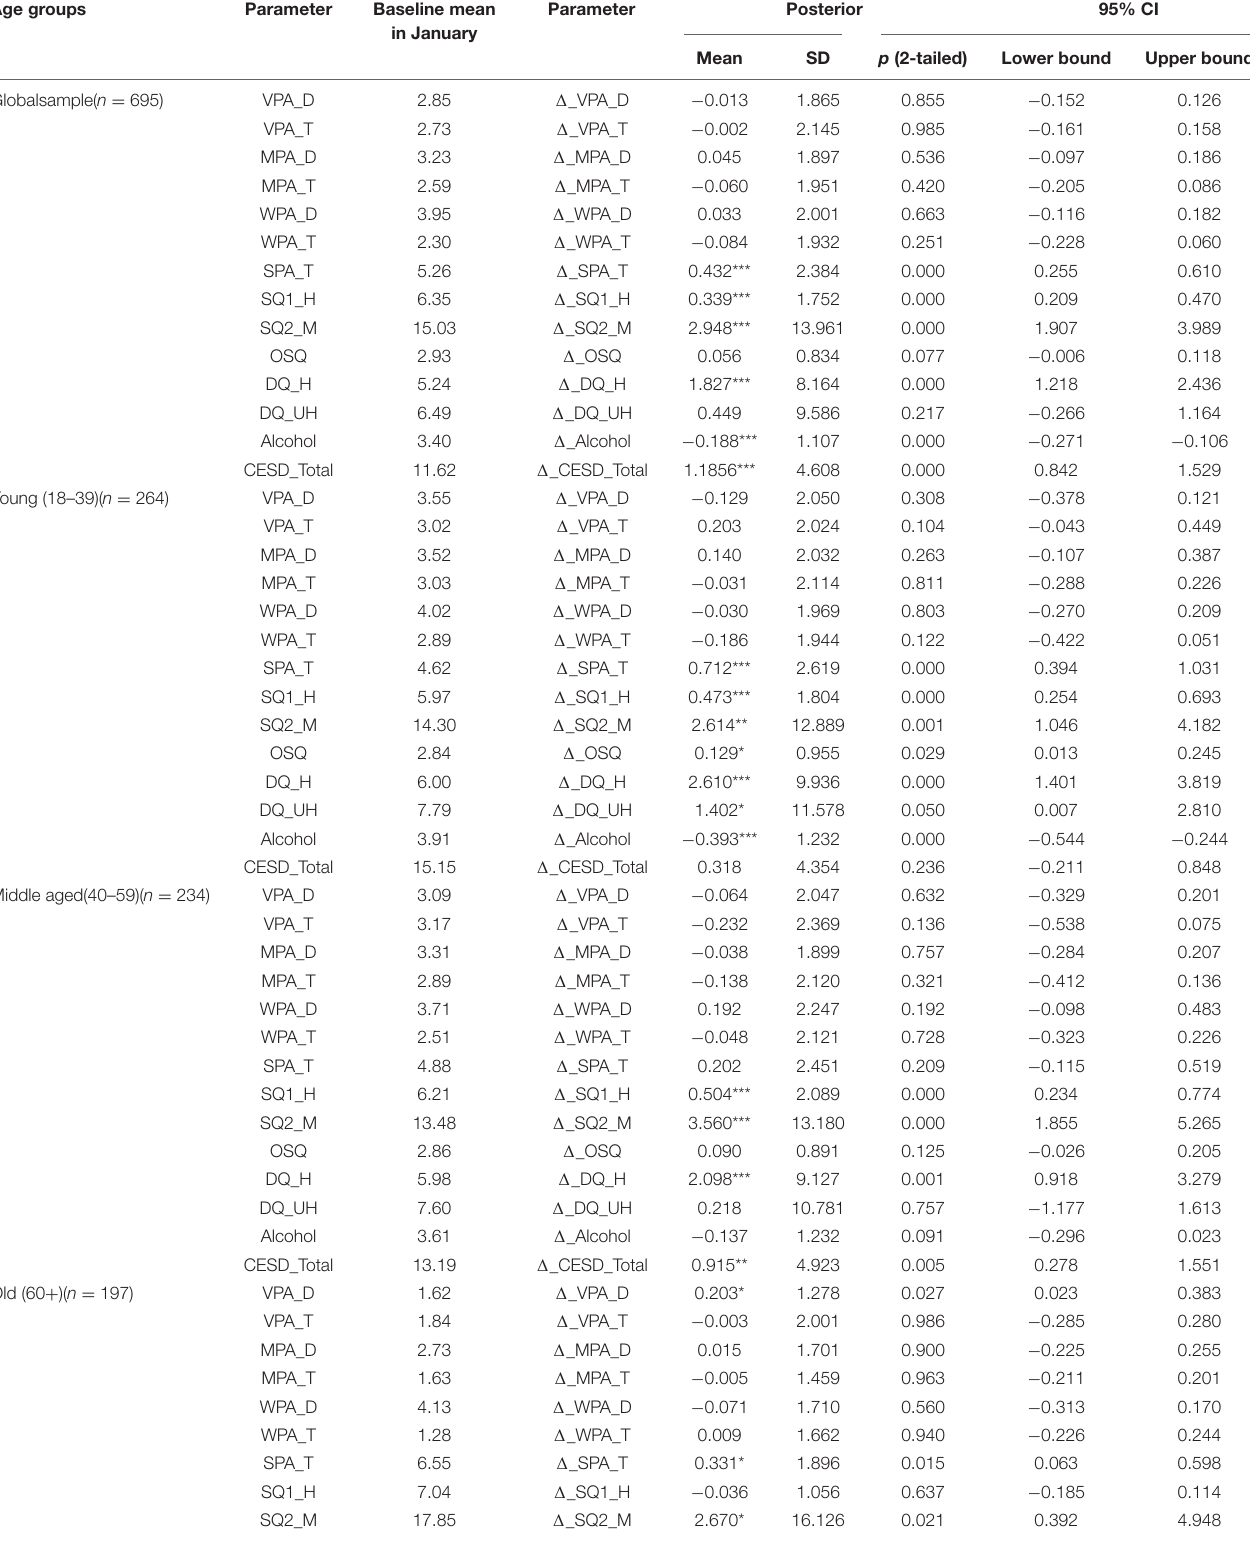
TABLE 2 | The significance of changes in health indicators by age groups using Bayesian t -tests. Age